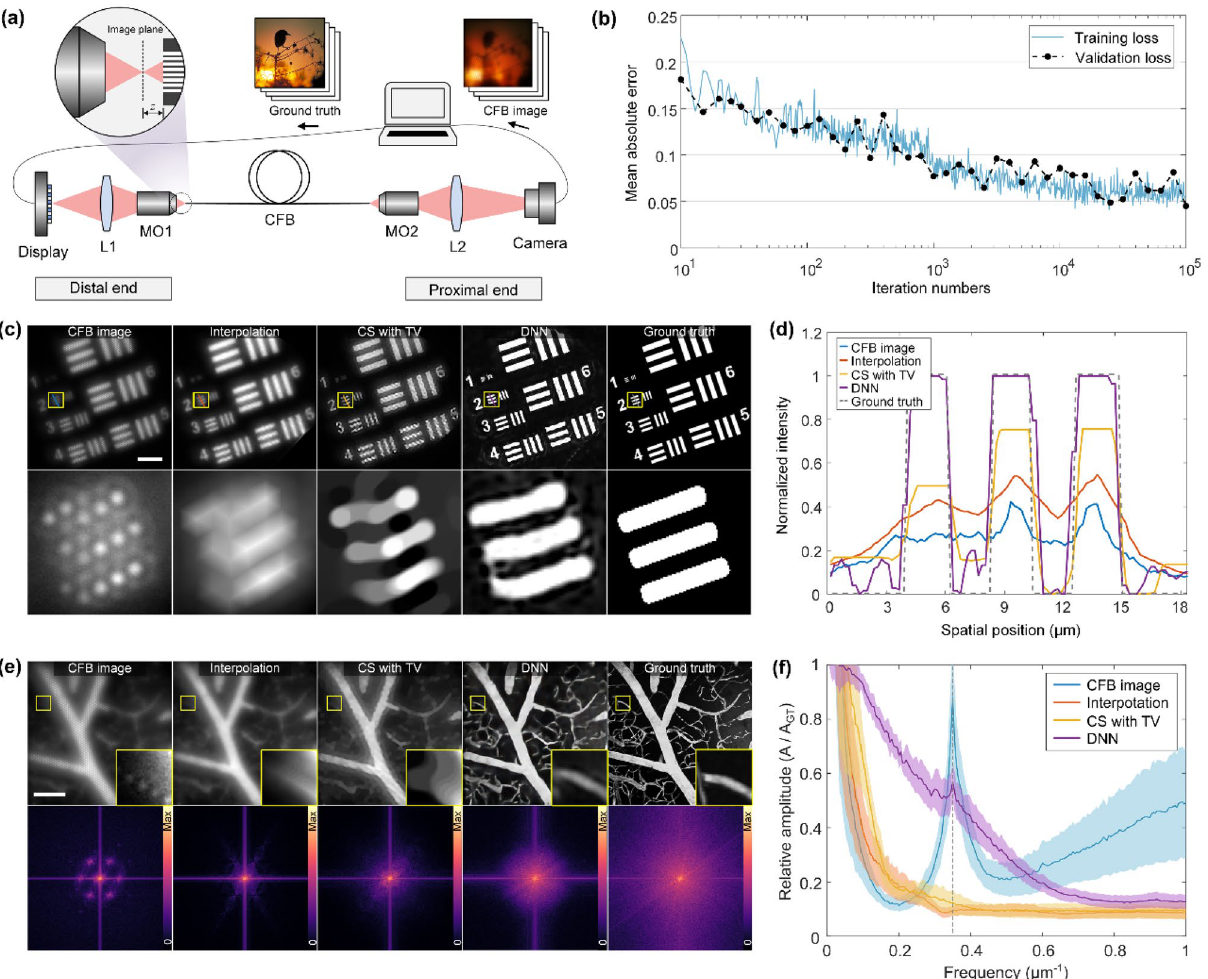
Figure 4. Image enhancement for the real CFB. ( a ) Experimental setup for dataset acquisition. The displayed images are projected to the optimal working distance z = 20 μm in front of the fiber fac images et. L, lens; MO, microscopic objective. ( b ) The change of loss function during training process. ( c ) Comparison of imaging results between different methods for resolution chart. Scale bar, 50 μm. ( d ) Cross section on Group-2 for each method. ( e ) Comparison of frequency domain characteristics of different image enhancement methods. The closeups show the details of tiny vessels. Scale bar, 40 μm. The corresponding spectrum maps are shown in the bottom of spatial images. ( f ) Radial normalized amplitude of spectrums. Plotted are the mean (line) and 95% confidence interval (shading) over 10 images. The dashed line indicates the core sampling